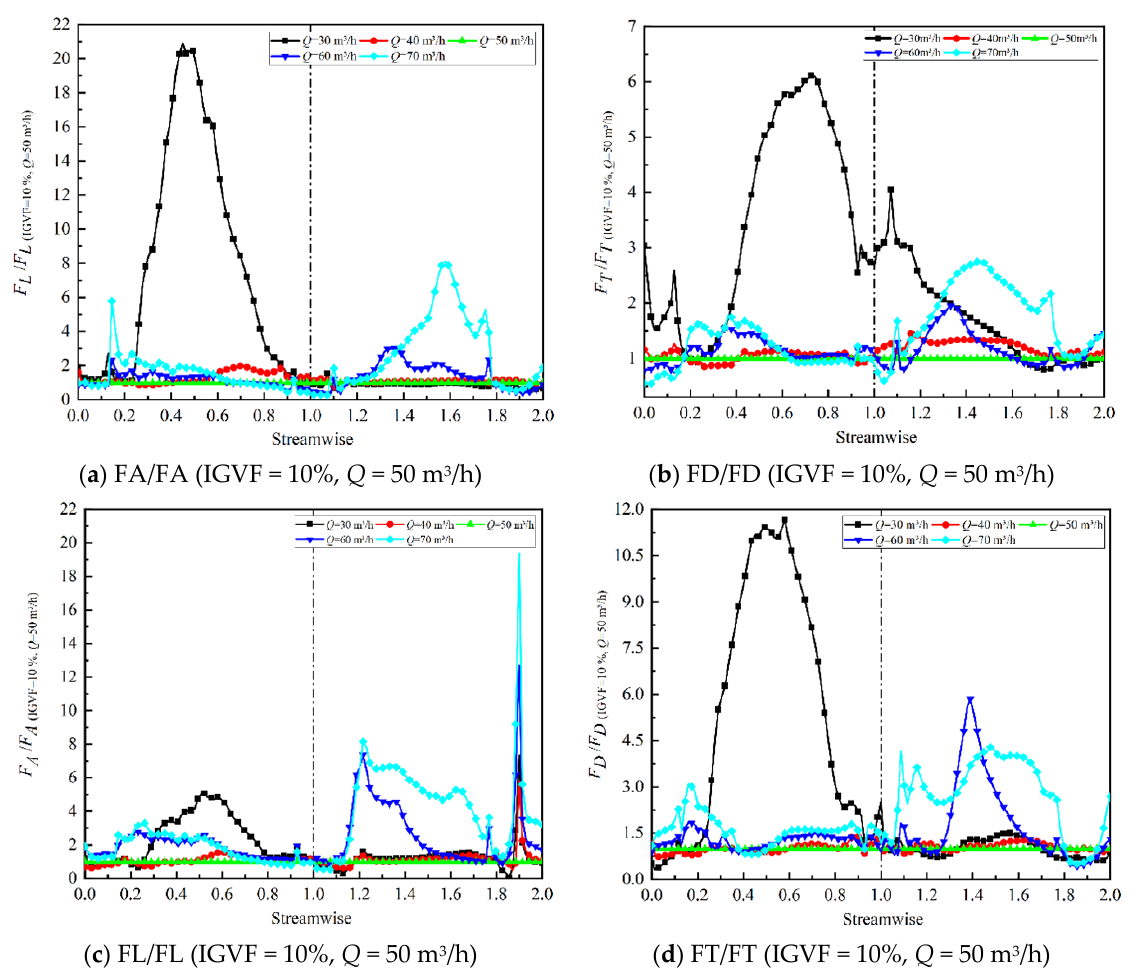
Figure 14. Magnitude ratio of interphase forces under different flow rates (IGVF = 10%, Q = 50m 3